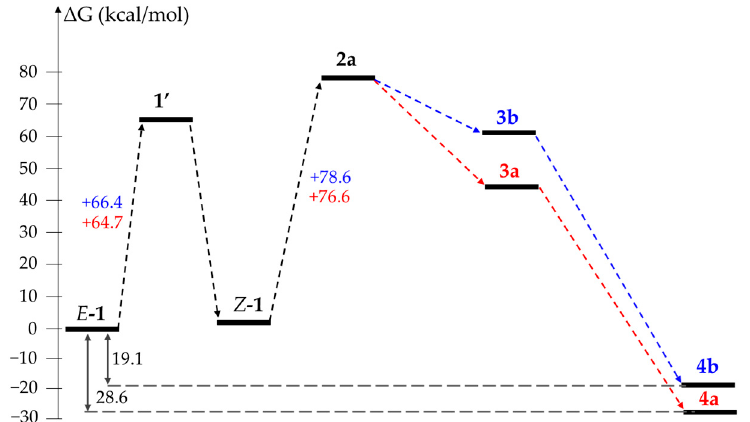
Figure 2. Optimized geometries of studied reaction intermediates for 1b → 4b transformation.